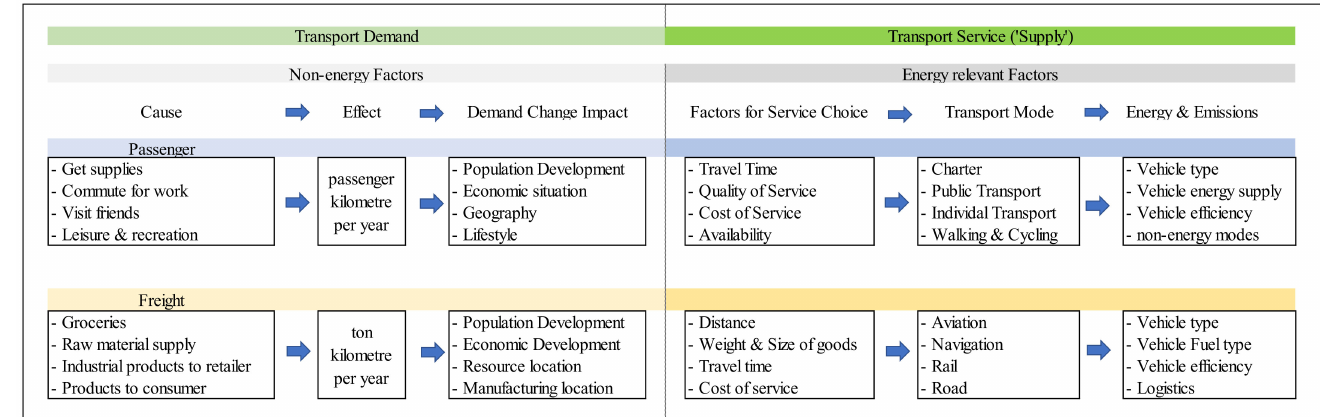
Figure 4. Calculation of Transport energy